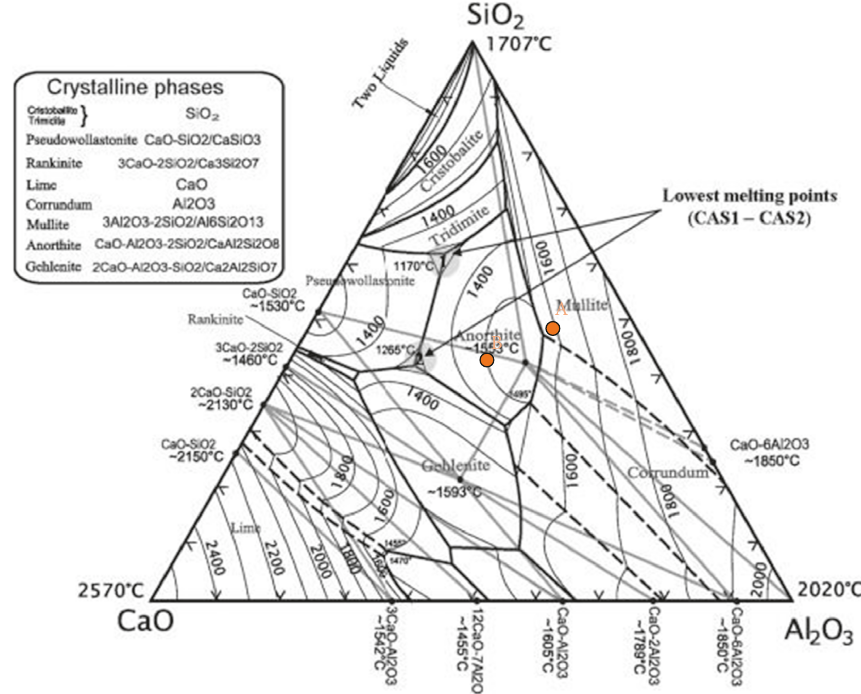
Figure 12: The SiO 2 -Al 2 O 3 -CaO phase diagram [37].